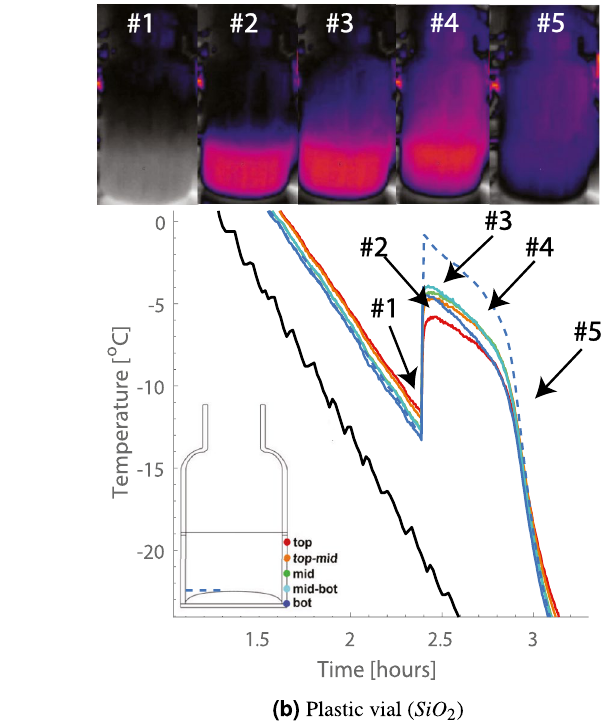
Figure 9. Temperature profile measured by the sensing elements and thermal camera shots (5 moments of time) for the glass and the plastic vials during the freezing stage of 4 ml 5% mannitol